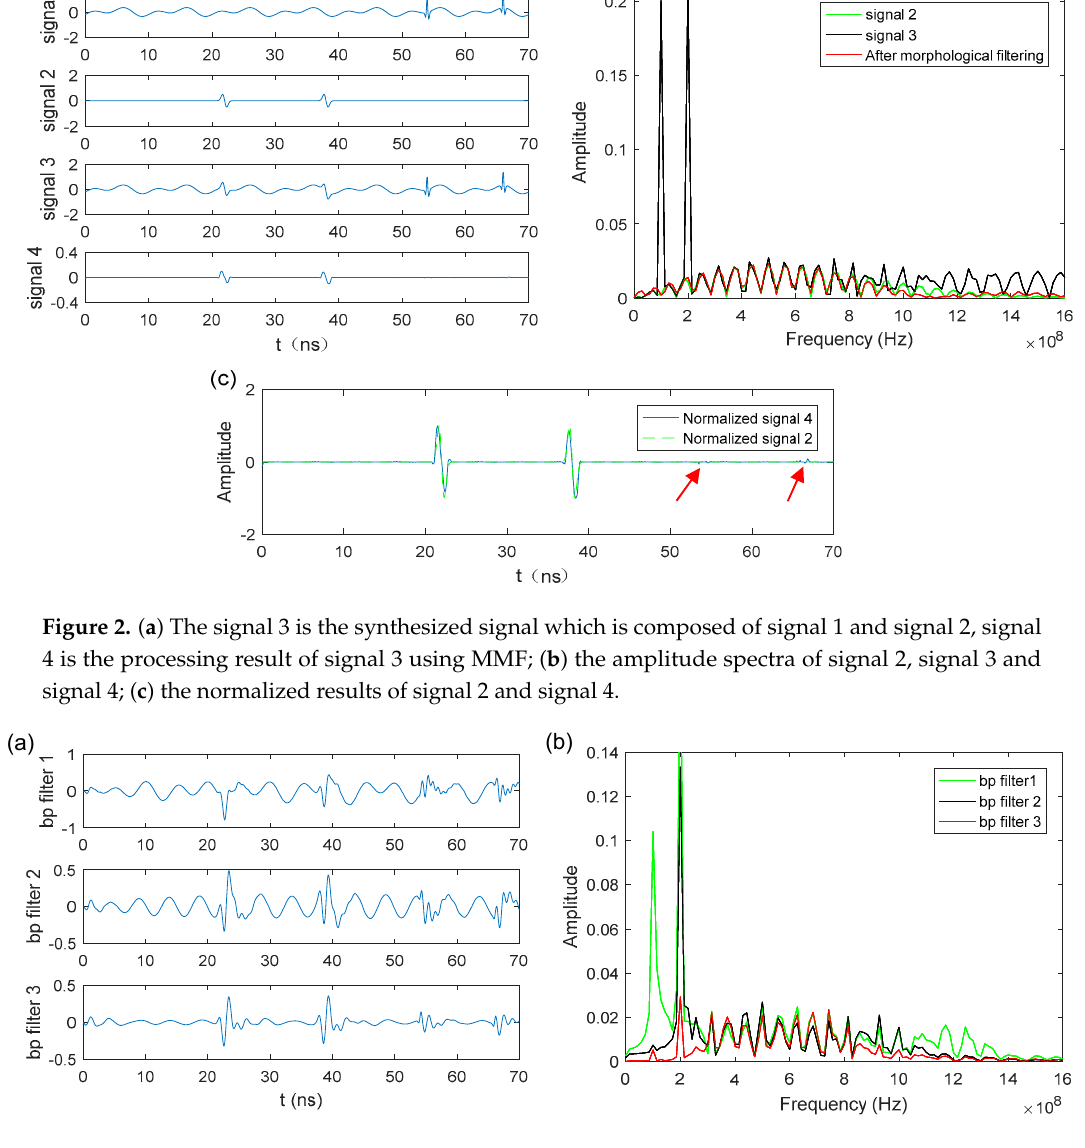
Figure 3. ( a ) The denoised results of the synthetic signal using band-pass filters; ( b ) the corresponding amplitude spectra of the results in Figure